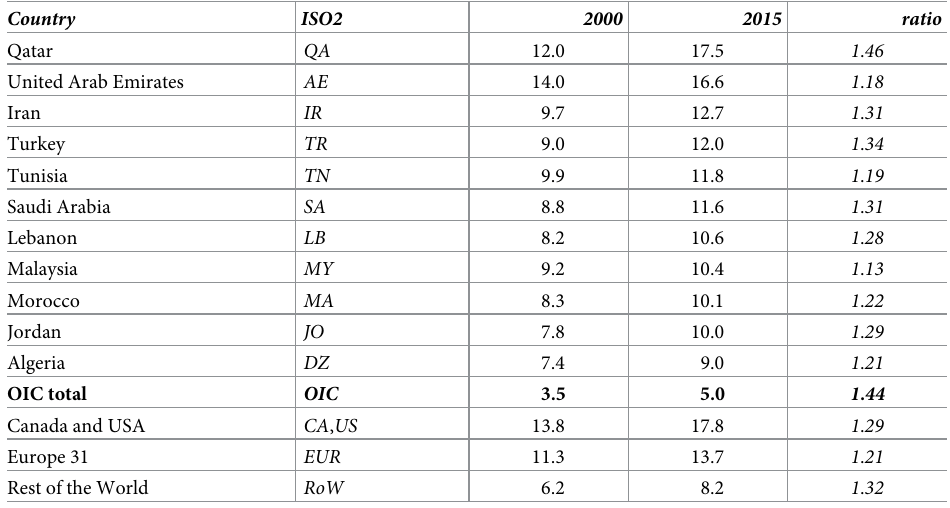
Table 2. Percentages of total DALYs from mental disorders in some OIC countries in 2000 and 2015, the ratio between them, and corresponding percentages for other country groups. Country ISO2 2000 Qatar